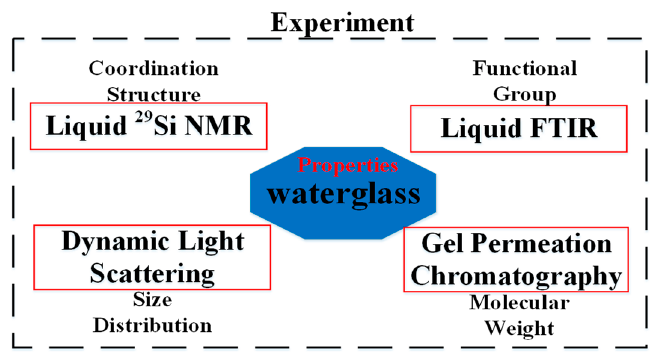
Figure 2. Properties of waterglass.